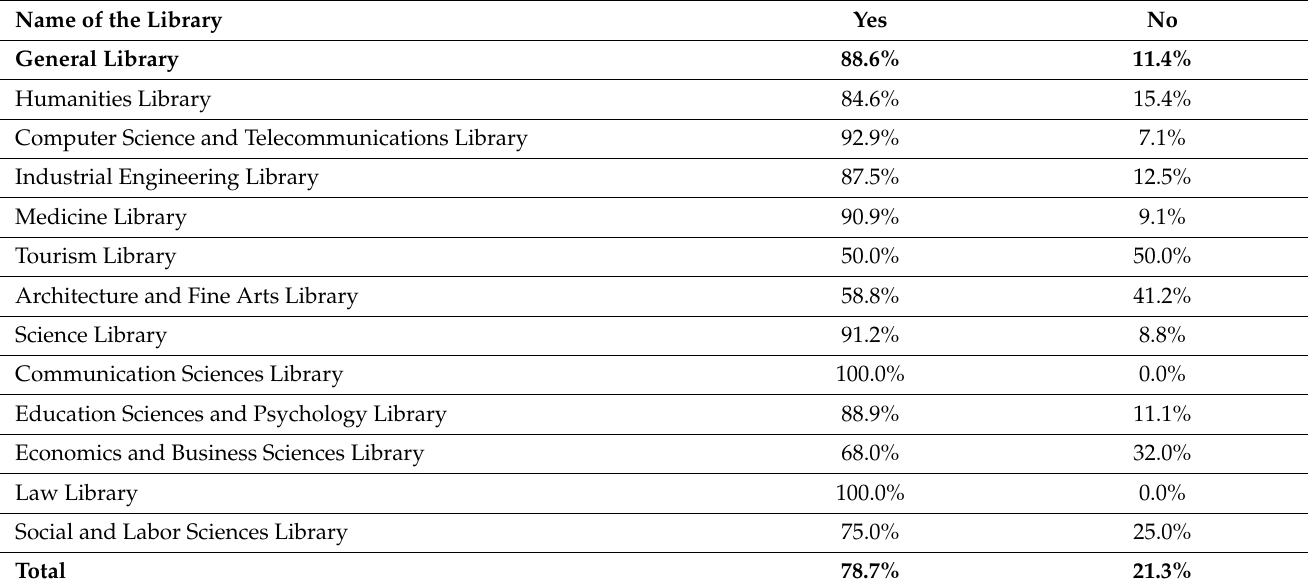
Table 4. Difficulty in reserving a seat during exam periods according to the most commonly used UMA libraries.